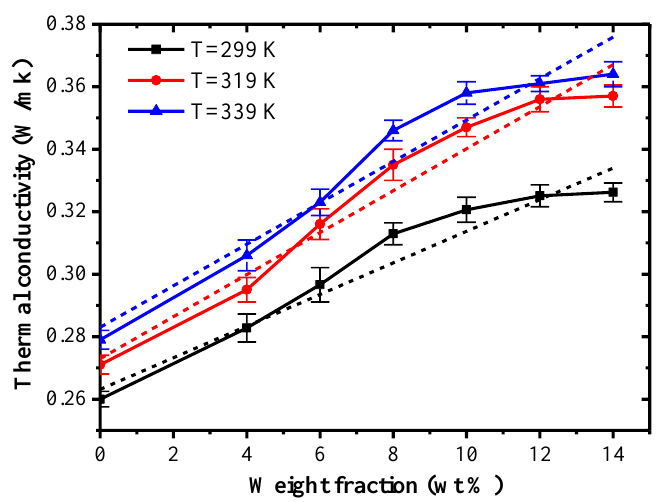
Figure 6. Thermal conductivity of composite systems with different carbon fiber contents at different temperatures.